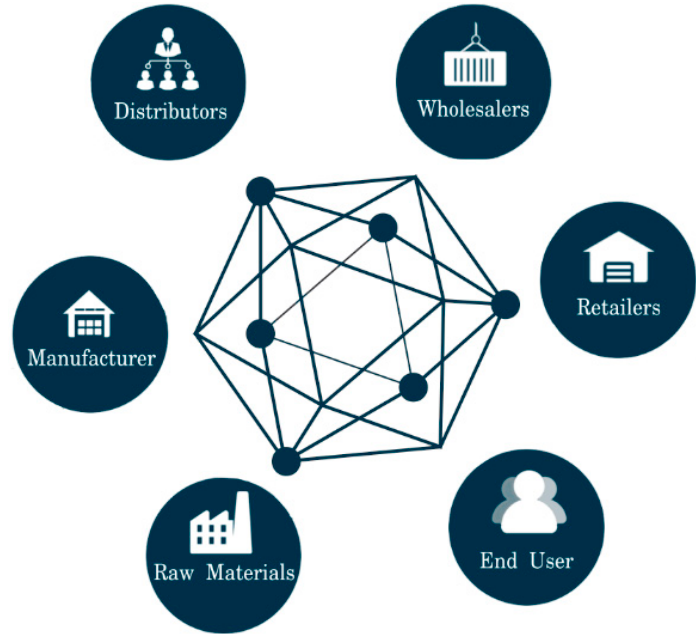
Figure 1 . Supply Chain Roles (Actors) interacting with Blockchain Distributed Ledger Technology . Figure 1. Supply Chain Roles (Actors) interacting with Blockchain Distributed Ledger